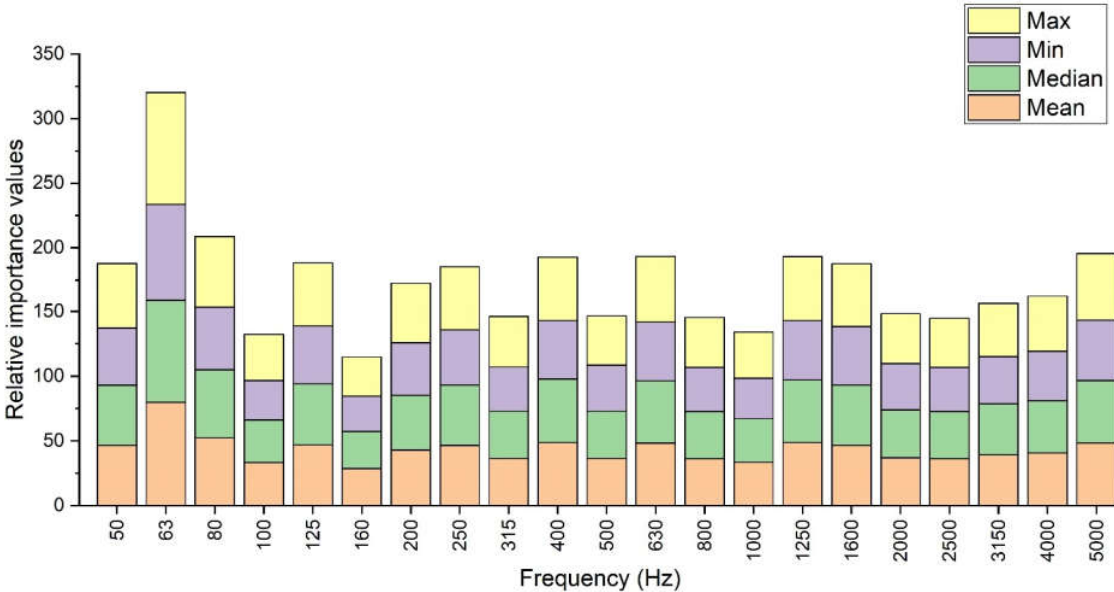
Figure 7. Attribute importance for all the features (one-third frequency components) determined by the Boruta algorithm. For each frequency, the values of the statistics shown in Table 2 are reported: mean, median, min, and max. In this way, it is possible to obtain a graphical comparison of the importance that each feature assumes in the classification of wind farm operation.